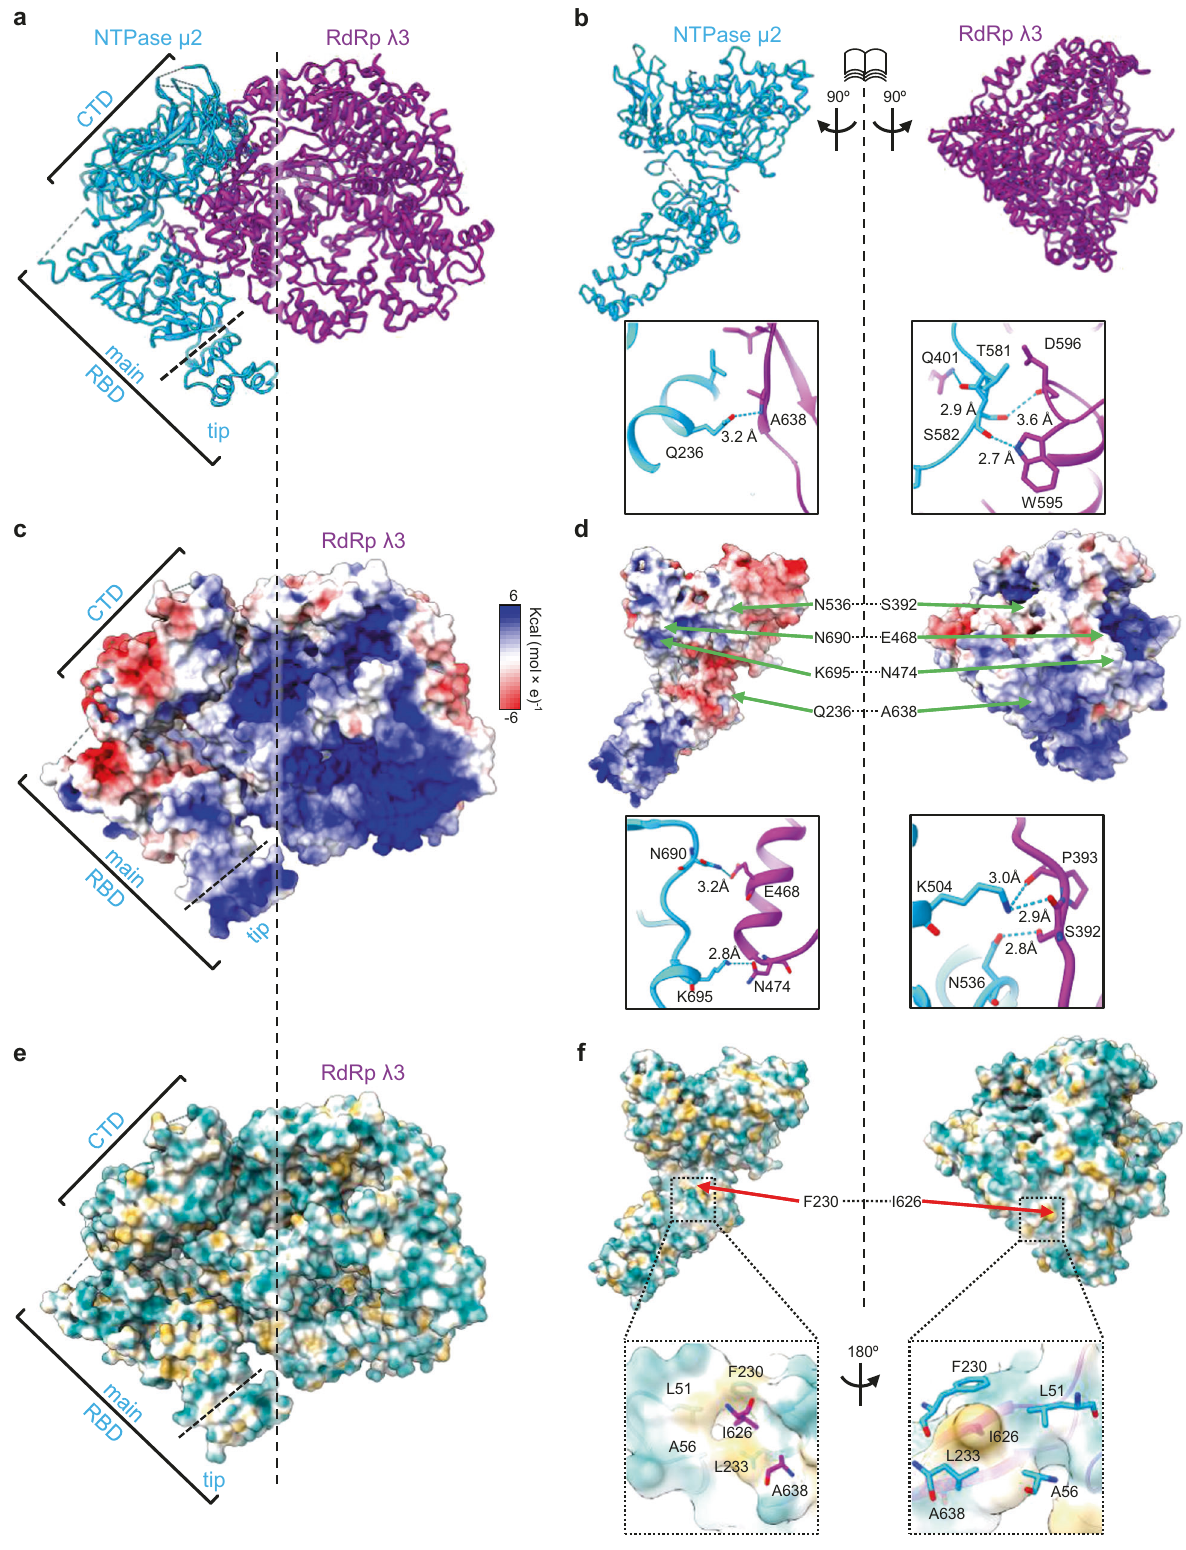
Fig. 3 The interface between RdRp λ 3 and NTPase μ 2 and identi fi cation of key interacting residues. a , b Ribbon representation of TEC ( a ), and NTPase μ 2 and RdRp λ 3 rotated 90° in opposite directions, exposing the interface and the interacting residues between the two proteins ( b ). c , d Same view as ( a , b ), with positive, neutral, and negative electrostatic potentials indicated in blue, white, and red, respectively. e , f Same view as ( a , b ), with hydrophilic, neutral, and hydrophobic area, indicated in cyan, white, and gold,